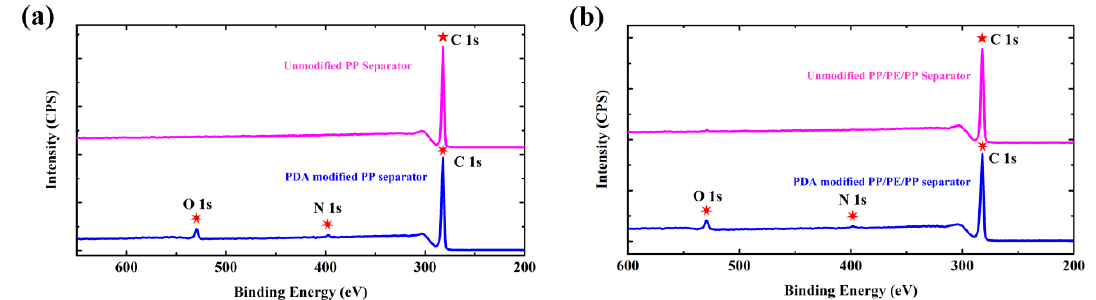
Figure 4. High-resolution X-ray photoelectron spectroscopy (XPS) spectra of separators (including C 1s, O 1s and N 1s): ( a ) unmodified and PDA-modified PP separators; ( b ) unmodified and PDA-modified PP/PE/PP separators.